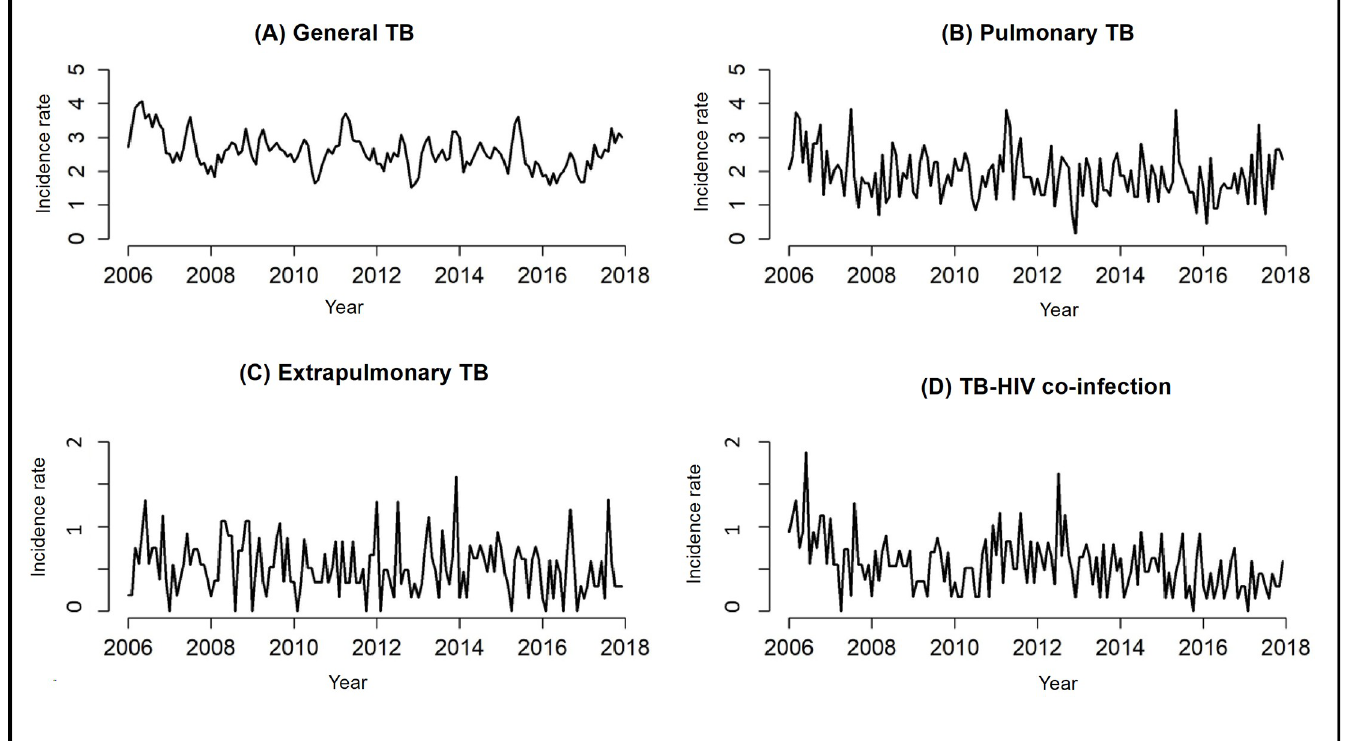
Fig 1. Tuberculosis incidence rates in Ribeir ã o Preto, S ã o Paulo, Brazil (2006–2017).